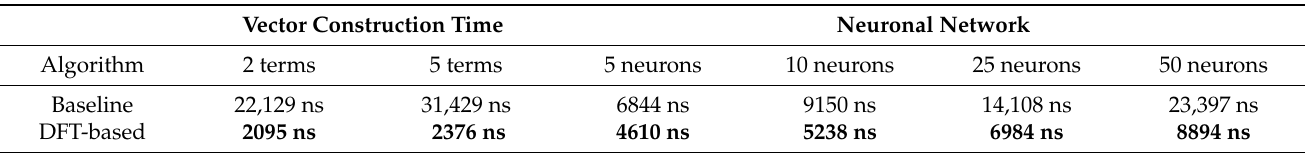
Table 6. Running time in nanoseconds reported by both the proposed algorithm and the baseline algorithm. The best results are highlighted in boldface type.